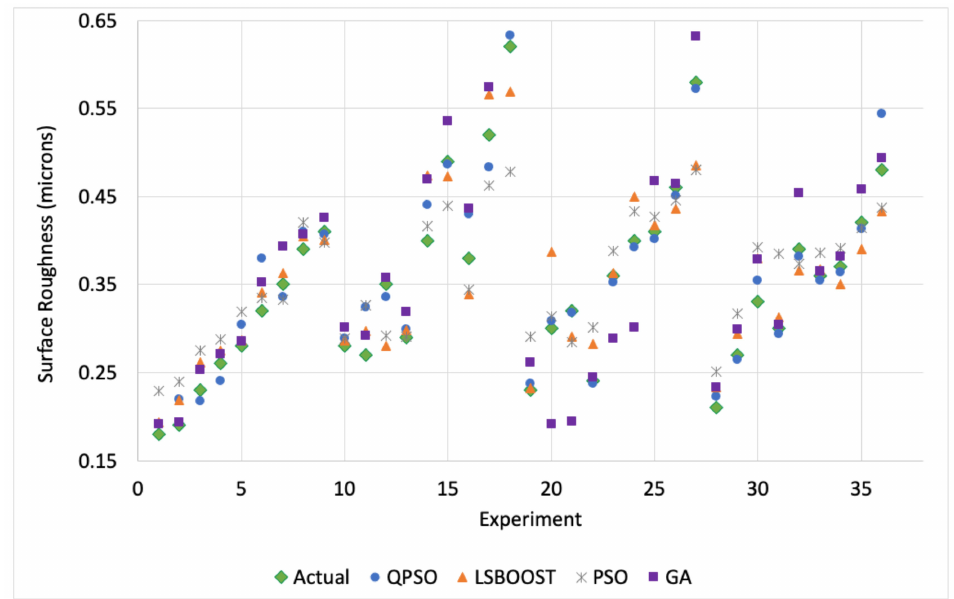
Figure 1. Actual surface roughness values with the predicted values by QPSO, LSBoost, PSO and GA algorithms.